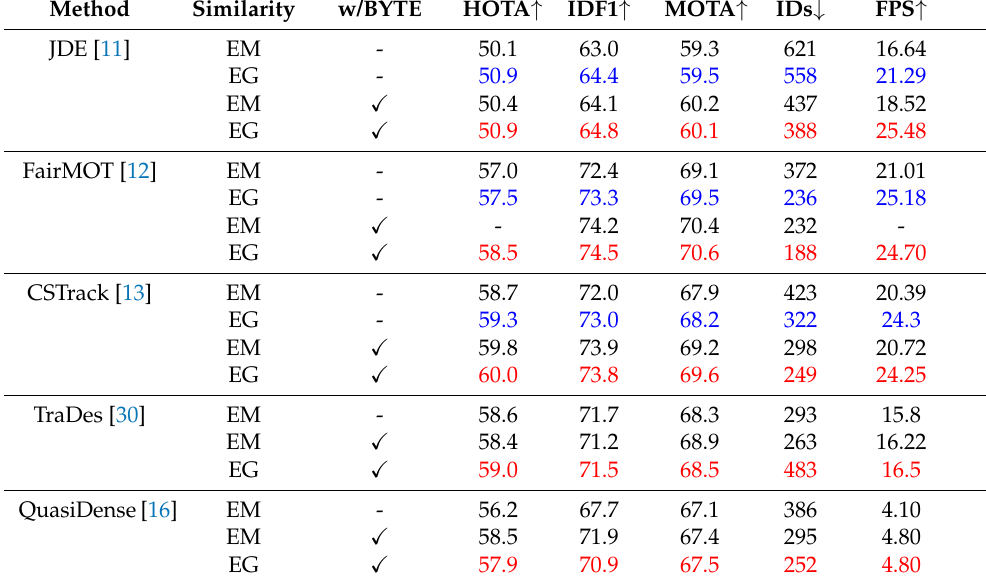
Table 5. Results of applying SimpleTrack to five different JDE-based trackers on the MOT17 validation set. Blue represents the tracking method using only the EG matrix, and red represents the tracking method combining the EG matrix and BYTE.